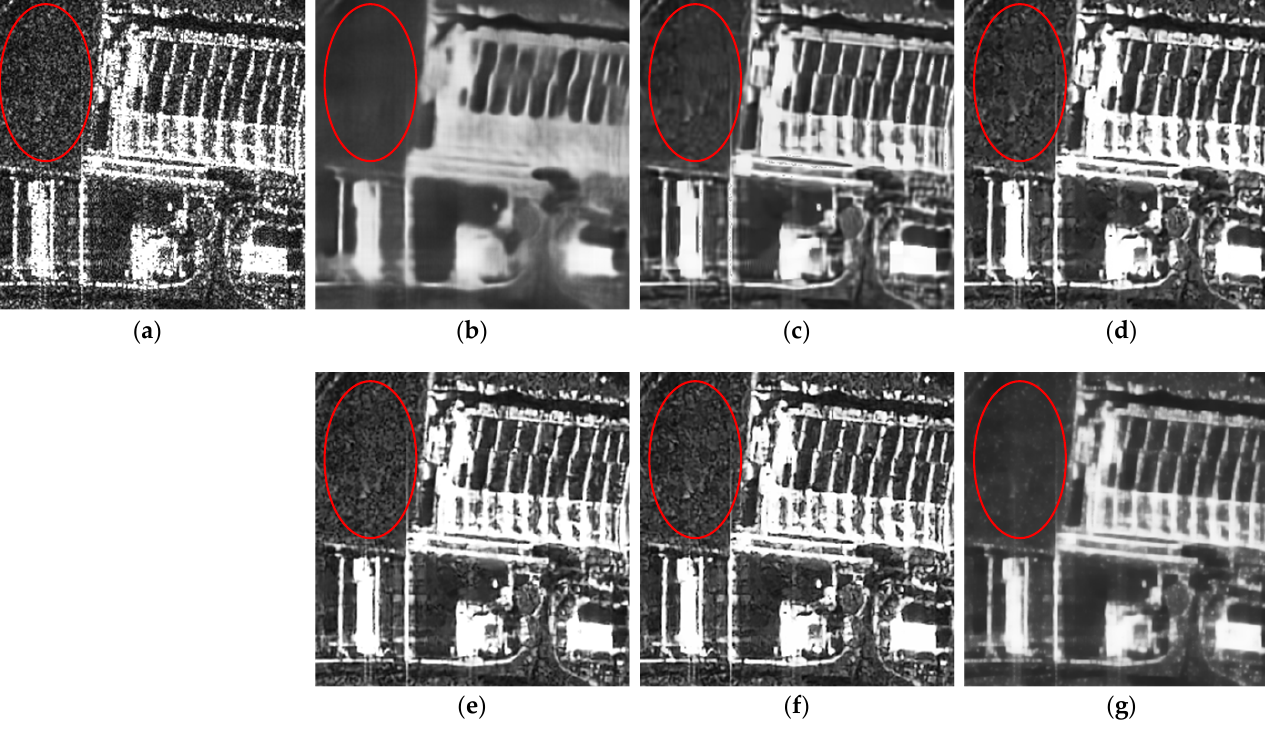
Figure 14. Magnified despeckling results for the TerraSAR-X #2 image. ( a ) Speckled. ( b ) PPB. ( c ) SAR-BM3D. ( d )